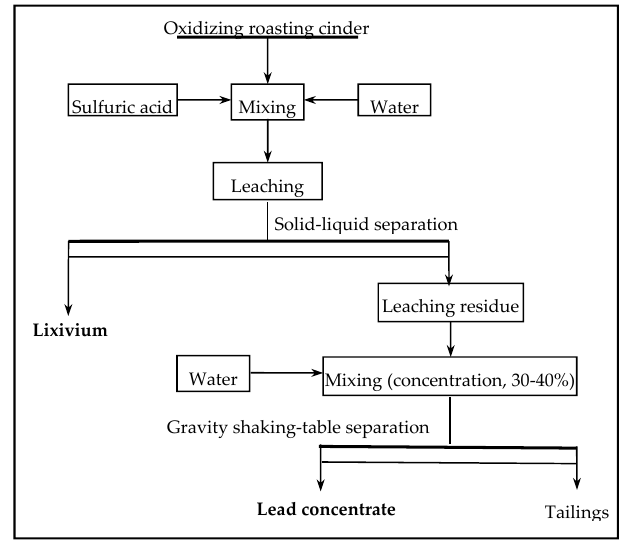
Figure 3. Scheme of the extraction of lead and zinc process from the oxidizing roasting cinder.